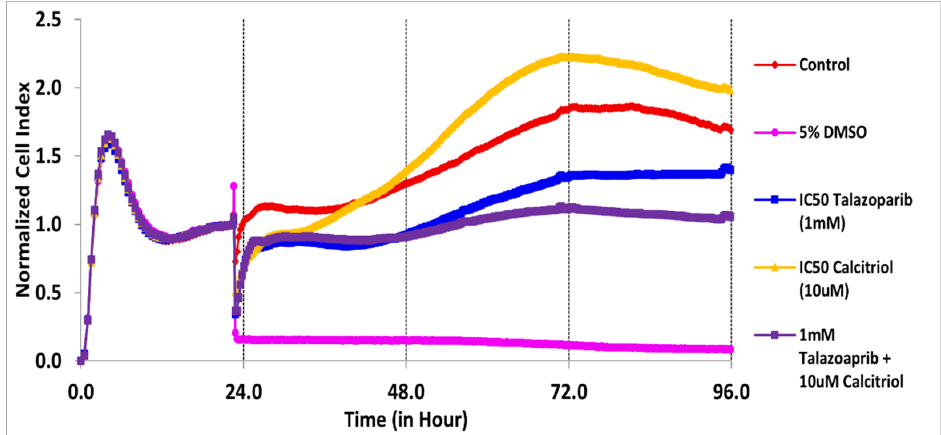
Figure 4. Treatment effects in MRC − 5 using MDA − MB − 468 concentration. Cells were seeded overnight to reach the log phase, then incubated with 1 mM talazoparib and 10 µM calcitriol for 96 h. Data are represented as the mean ± SD ( n = 3). The drugs were added after 24 h. The pink color line is the positive control (5% DMSO). Raw data can be found in Supplementary File S4.